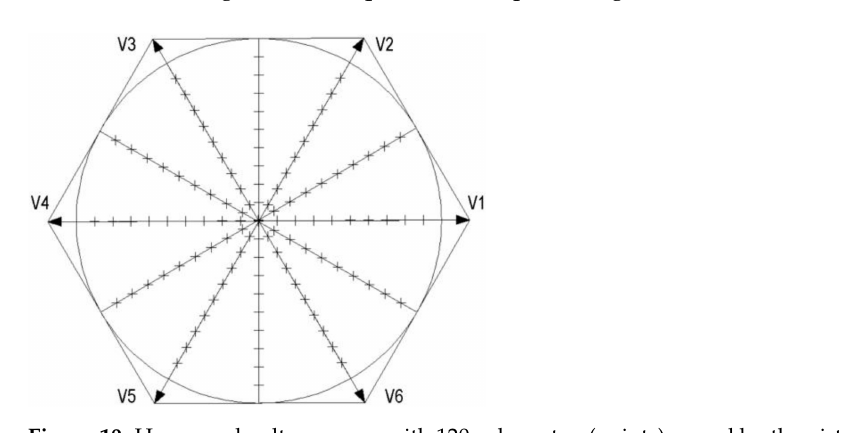
Figure 10. Hexagonal voltage space with 120 sub-vectors(points)—used by the virtual vector model predictive control.